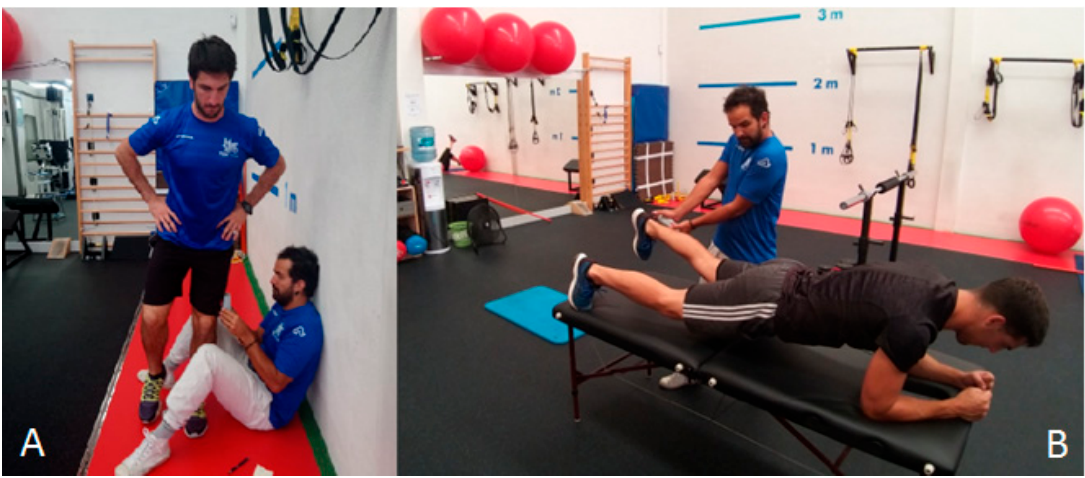
Figure 1. New proposed core functional strength field tests. ( A) Closed Kinetic Chain Test (CCT). ( B ) Prone Plank Test (PPT).